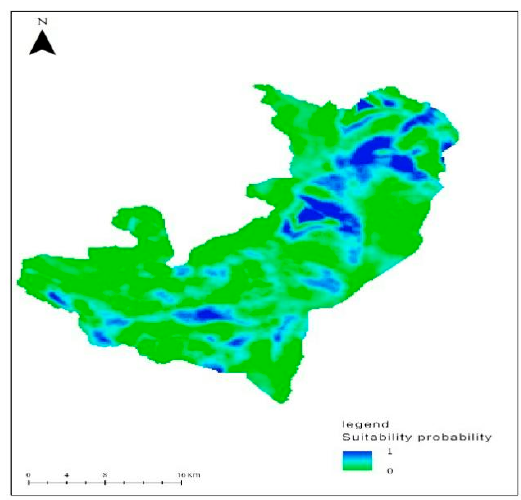
Figure 2. The suitability distribution of the red deer winter habitat in Gogostaihanwula, Inner Mongolia.